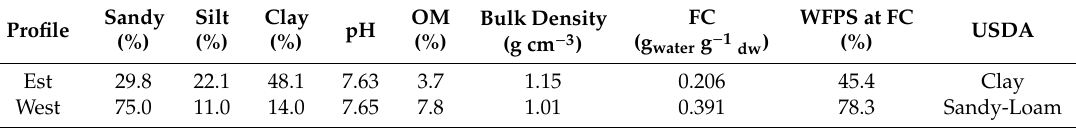
Table 1. Physical and chemical soil properties. OM—organic matter; FC—water field capacity; WFPS—water filled pore space at field capacity.